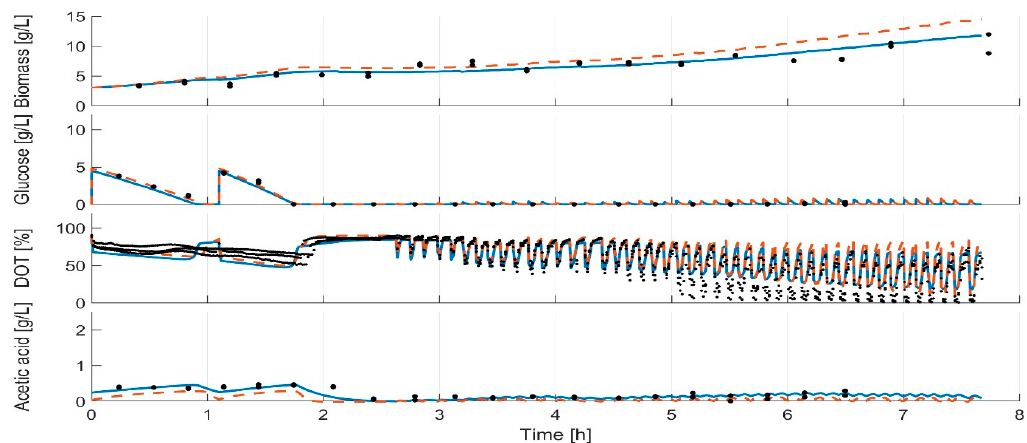
Figure 6. Model for E. coli BW25113 Δ glcB after the last model calibration cycle and at the beginning of the experiment. Solid line: calibrated model; dashed line: initial model; dots: measurements.